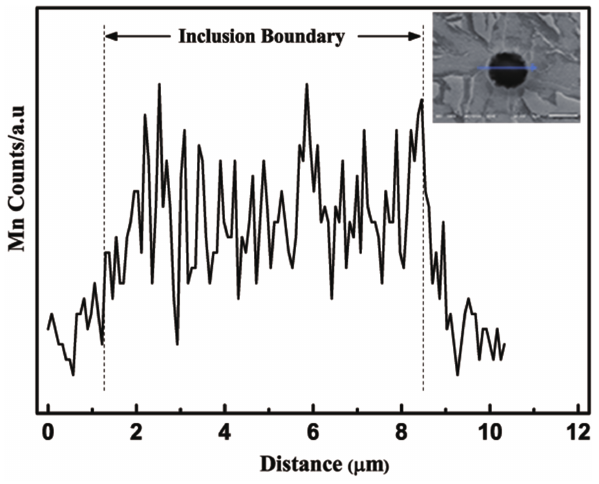
Figure 5: Line scanning analysis of Mn content along the nucleation site of inclusion and surrounding steel